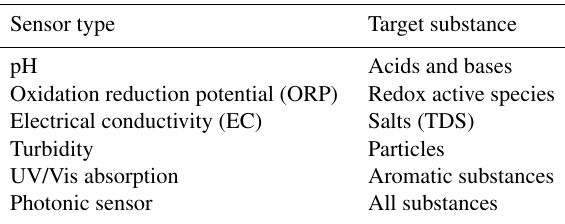
Figure 2. Evaluation of salinity/TDS in water.